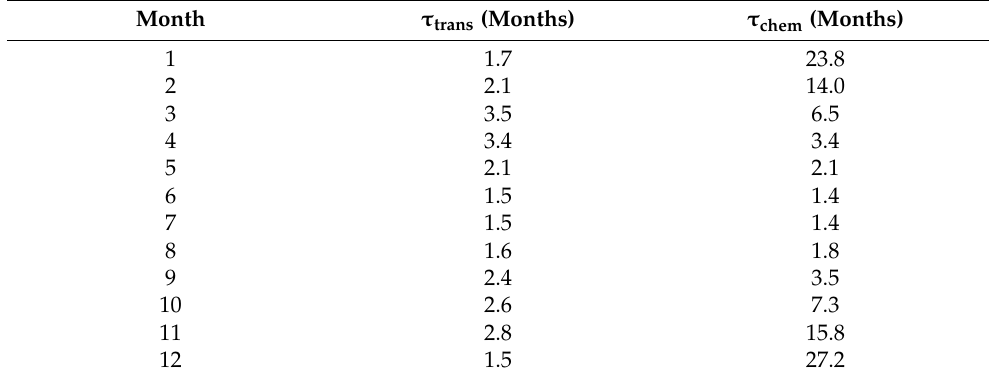
Table A1. Monthly mean characteristic times for air exchange between High and Low Northern Hemispheres τ trans and photochemical lifetime τ chem .